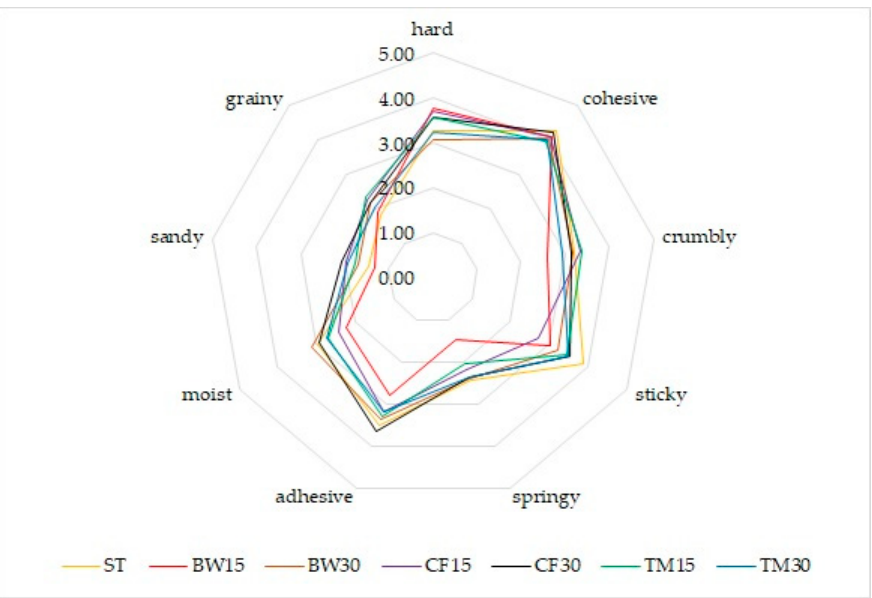
Figure 3. Organoleptic characteristics of bars—texture profile.